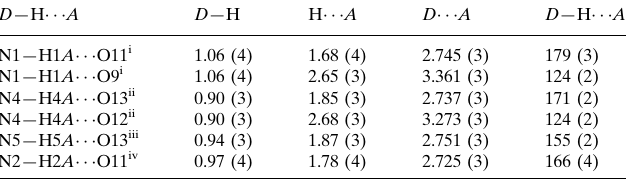
Hydrogen-bond geometry (A˚ , (cid:4)